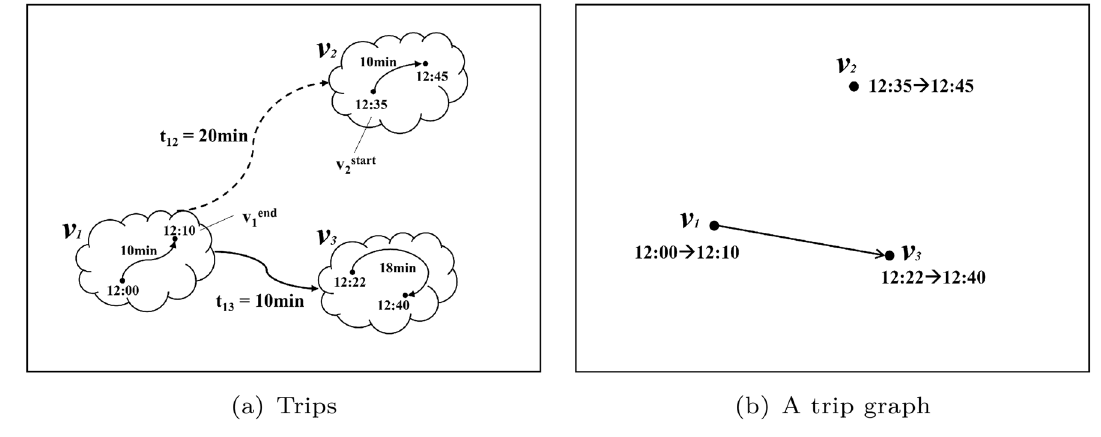
Fig. 2 An example of a trip graph Fig. 3 Sort and Search Algo-